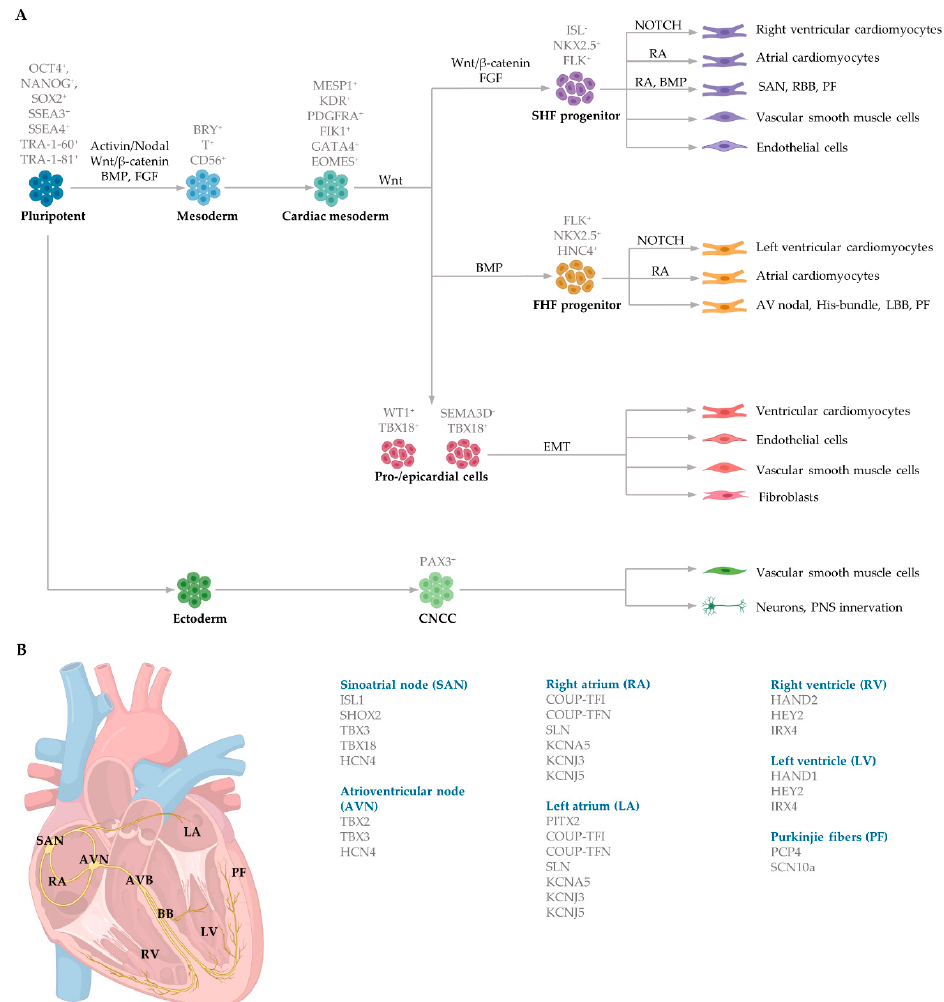
Figure 2. Schematic of embryonic cardiac commitment highlighting ( A ) key signalling pathways regulating each differentiation stage during cardiogenesis, including cell markers expressed during each stage, and ( B ) gene expression in distinct regions of the human heart. Mesoderm induction is induced in response to Activin/Nodal, Wnt/ β -catenin, BMP, and FGF signalling. Cardiac specification is regulated by MESP1, which coordinates the migration of early cardiovascular progenitors (ISL+) to the FHF and the SHF. The FHF progenitors generate the left ventricle, portions of the atria and conducting cells. The SHF progenitors contribute to the right ventricle, portions of the atria, conducting cells, vascular smooth muscle cells and endothelial cells. Epicardial cells undergo epithelial-to-mesenchymal transition to form fibroblasts, endothelial cells, vascular smooth muscle cells and parts of the ventricle. Ectoderm progenitors also generate vascular smooth muscle and neurons responsible for autonomic innervation. EMT, epithelial-to-mesenchymal transition. CNCC, cranial neural crest cells. RA, retinoic acid.